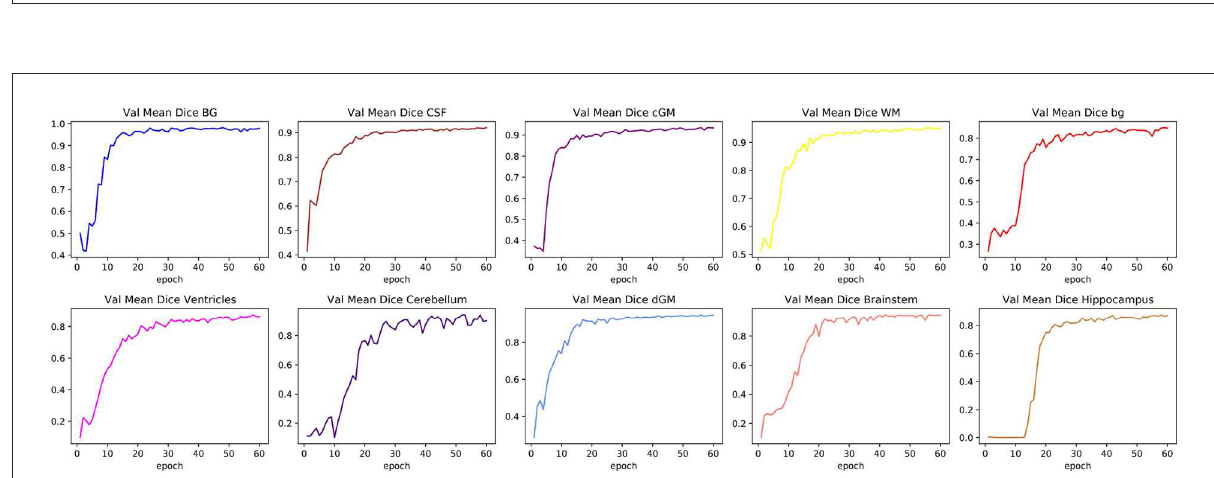
FIGURE9 Changes in validation DSC of AgeU-Net on all physiologically relevant tissues. A large proportion of the learning process took place within the first 20 epoch, similar to the initial model.